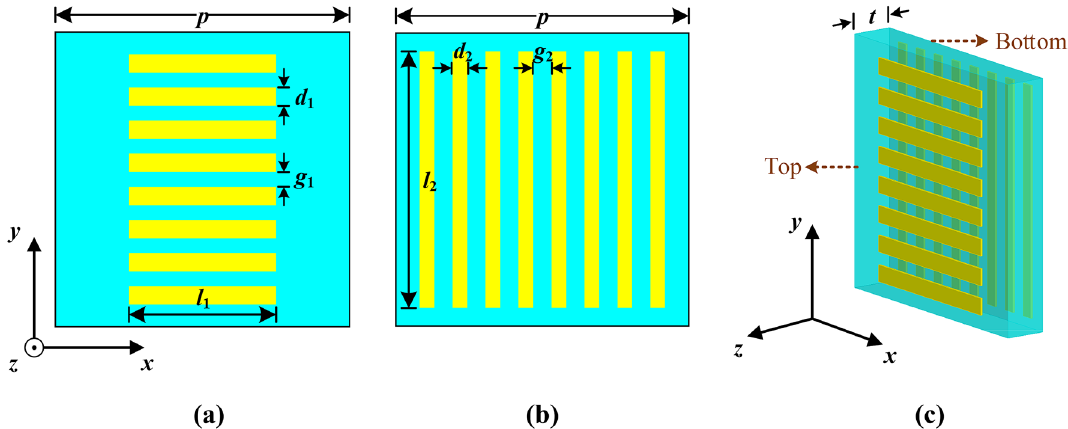
Figure 1. Configuration of the proposed anisotropic cell. ( a ) Top view. ( b ) Bottom view. ( c ) Perspective